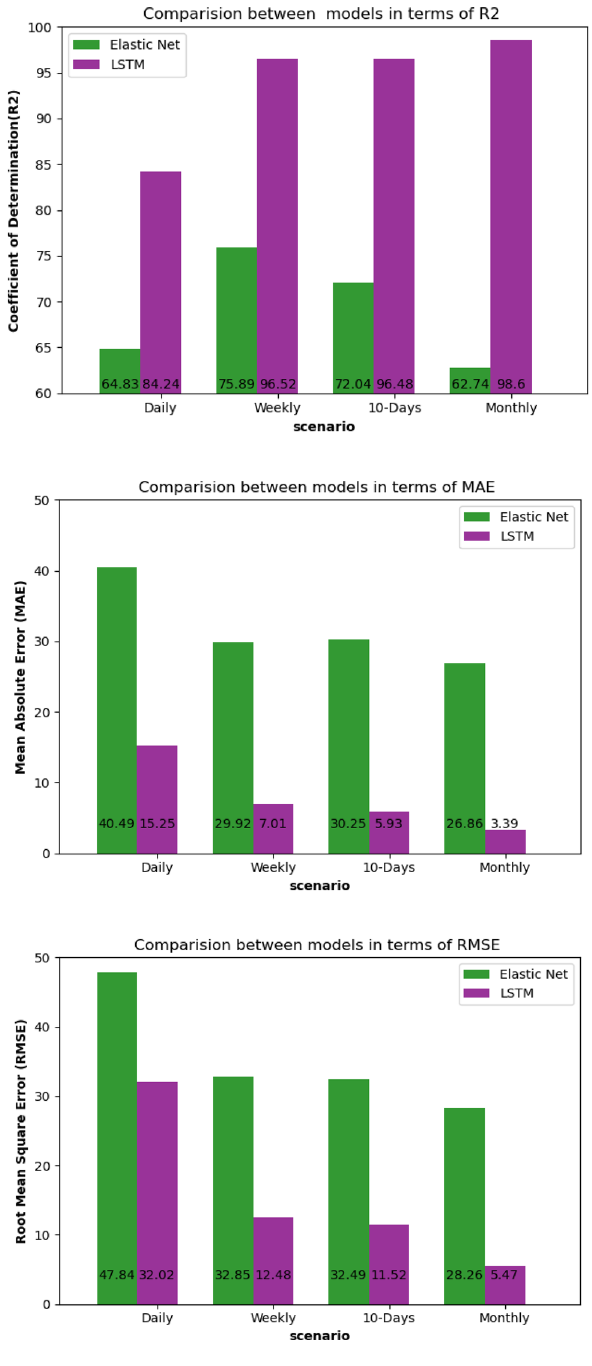
Figure 12. Comparison between Elastic Net L.R. and LSTM in terms of R 2 , MAE, RMSE for four scenarios when input is discharge at time